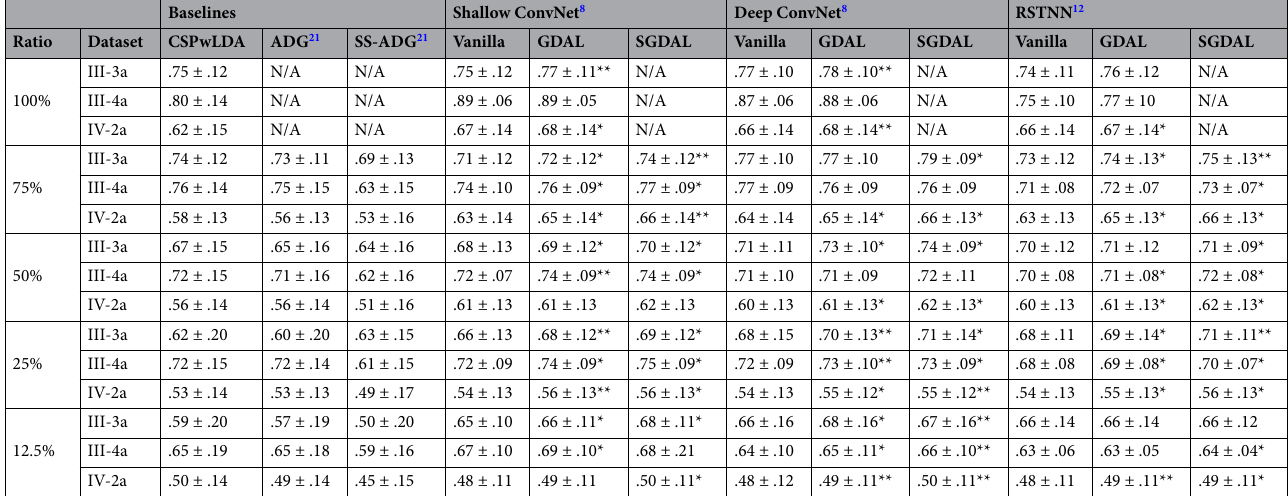
Table 1. Performance evaluation for every case. Ratio rows denote number of used training samples of each dataset, which is shown in the Dataset rows. Baselines column shows the performance of a conventional CSP and LDA method (CSPwLDA column), Lotte’s artificial EEG generation using time-frequency domain EEG 21 (ADG), and Lotte’s semi-supervised CSP and LDA method 21 (SS-ADG). Shallow ConvNet, Deep ConvNet 8 , and RSTNN 12 columns indicate the CNN architecture to demonstrate the classification performance of conventional modeling (Vanilla), the proposed adversarial modeling (GDAL), and semi-supervised adversarial modeling (SGDAL). * and ** denote p < 0.05 and p < 0.005 , respectively.